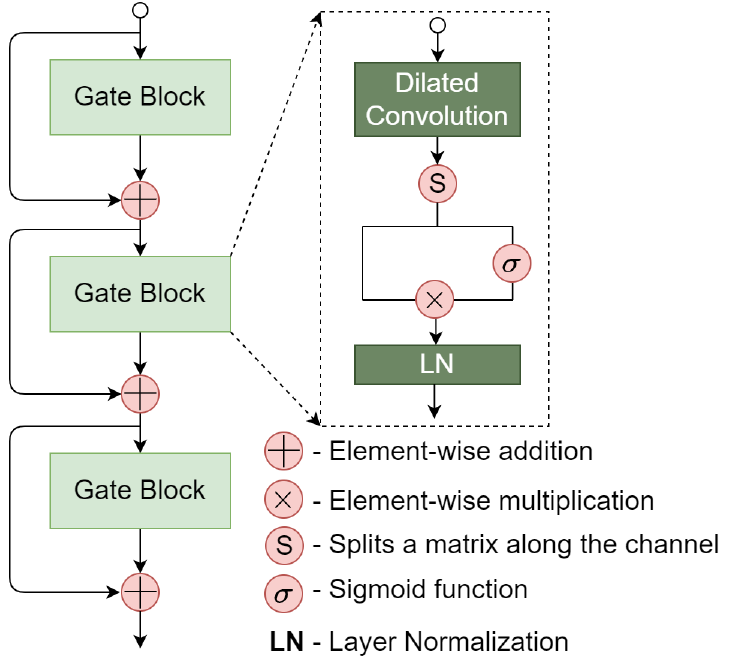
Figure 3. Illustration of the residual dilated GatedCNN module.